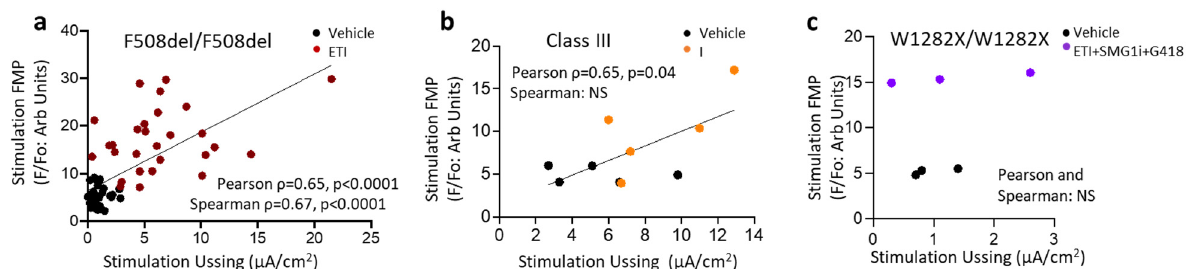
Figure 5. FMP correlation between donor-specific responses (i.e., stimulation) in FMP-based and Ussing chamber studies on primary nasal epithelial cultures of different genotypes: ( a ) FMP vs. Ussing responses in cultures from donors homozygous for F508del ( n = 31). The black symbols correspond to measurements obtained in the presence of the vehicle control. The dark red symbols represent measurements obtained in the presence of ETI. ( b ) FMP vs. Ussing responses in cultures from donors harbouring G551D or G178R ( n = 5). The black symbols denote measurements obtained using the vehicle control, while orange symbols denote the acute responses to forskolin plus ivacaftor (I). ( c ) FMP vs. Ussing responses in cultures from donors harbouring W1282X ( n = 3). Black symbols indicate measurements in the presence of DMSO, while purple symbols represent treatment with SMG1i, G418, and the triple-modulator combination in ETI. The line in ( a , b ) represents the simple linear regression line fi t for the data.